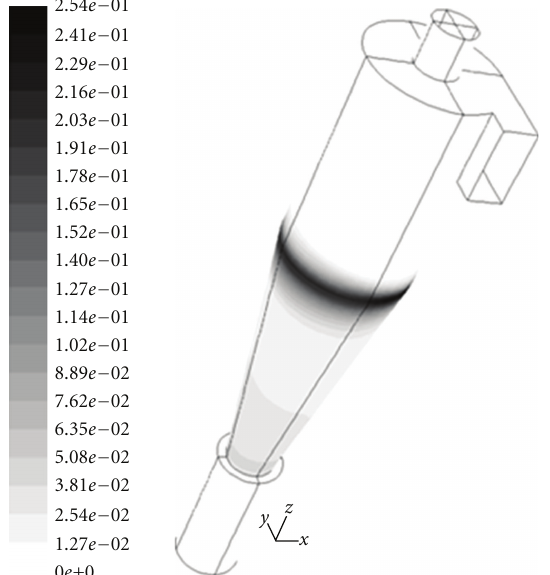
Figure 9: Particles volume fraction near the cyclone wall (1kg/m 3 ).